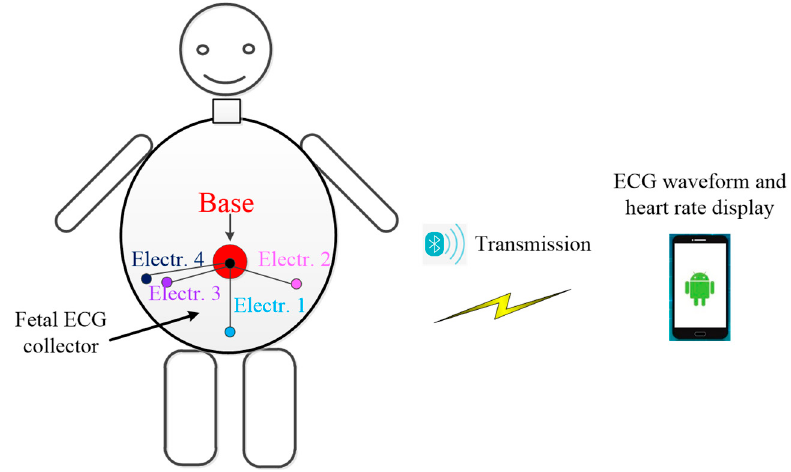
Figure 1. Illustration of the fetal ECG monitoring system.